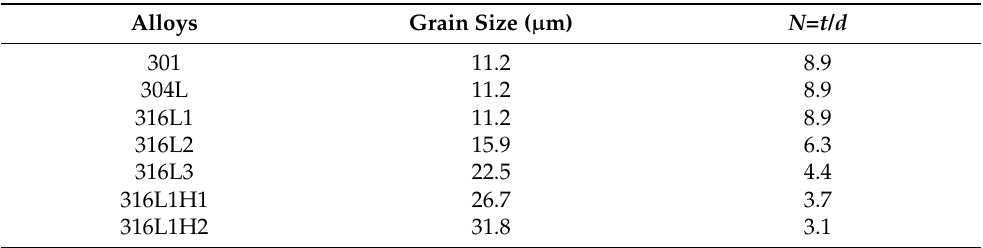
Table 2. Averaged grain size and thickness to grain size ratio, N, for the commercial and heat treated alloys.